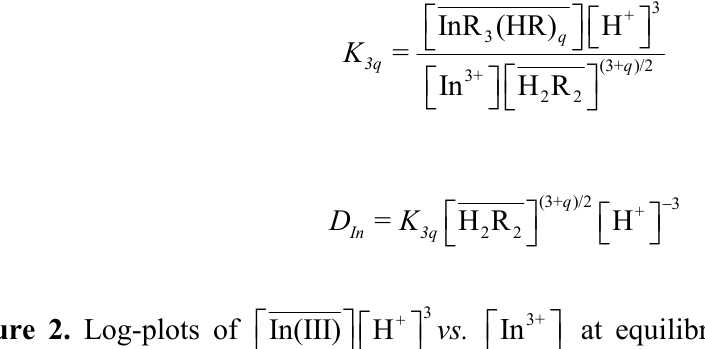
Figure 2. Log-plots of concentrations in kerosene at 25  C. [In 3+ ]